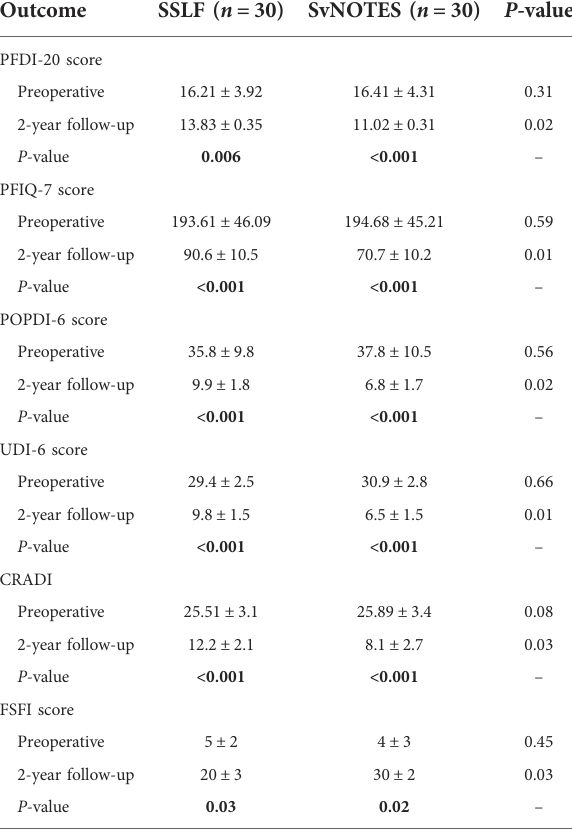
TABLE 5 Subjective symptom score at the 2-year follow-up. a